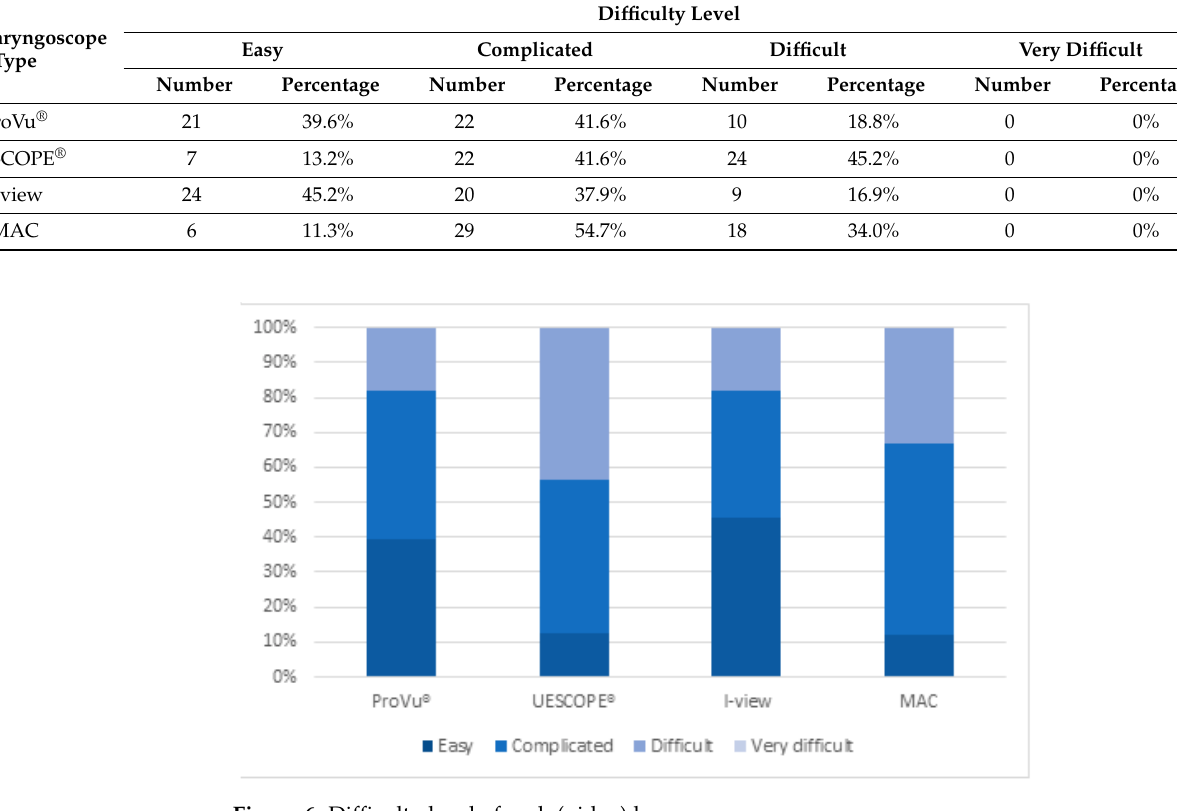
Figure 6. Difficulty level of each (video) Figure 6. Di ffi culty level of each (video) laryngoscope.